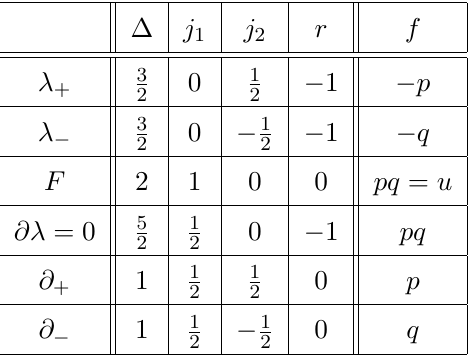
Table 1 . Letters and their charges in the N = 1 vectormultiplet index.